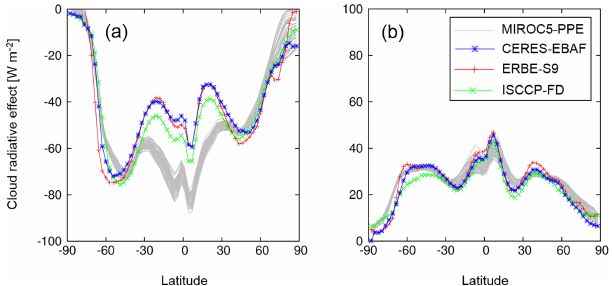
Figure 2. TOA radiation in the zonal annual mean for the (a) short- wave CRE and (b) longwave CRE components. The unit is Wm − 2 and the signs are positive